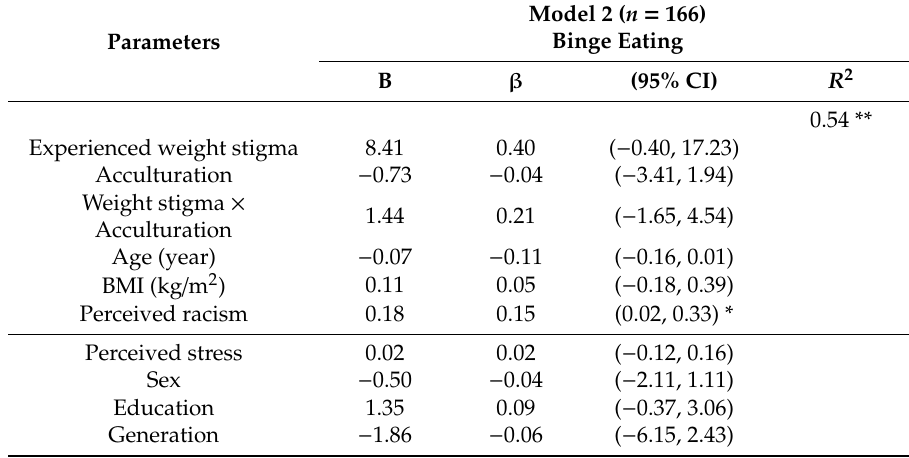
Table 5. Results from a multiple linear regression for the moderating role of acculturation between the experienced weight stigma and binge eating. Model 2 ( n = 166) Binge Eating Parameters B β (95% CI) R 2 0.54 **